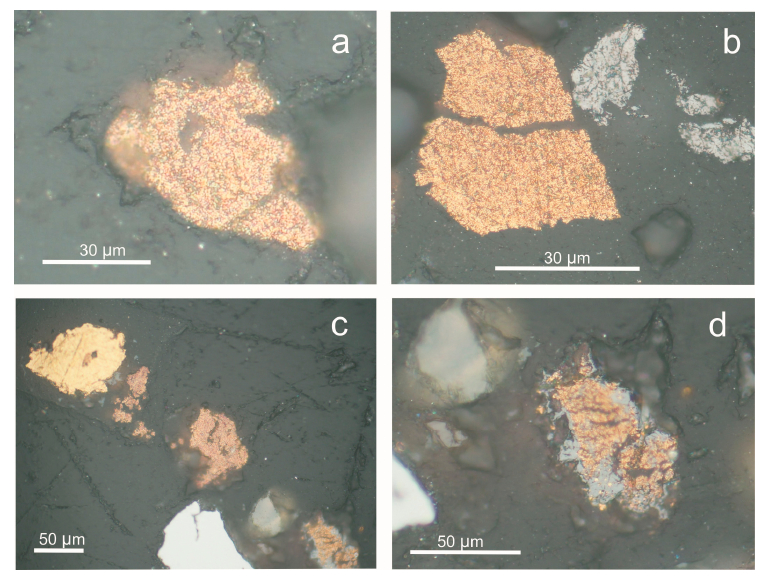
Figure 3. Reflected light photomicrograph of mustard gold ( a – c ) compared with primary gold (yellow) and pyrite (white) ( c ) and with Fe–Sb oxide (gray; b , d ).